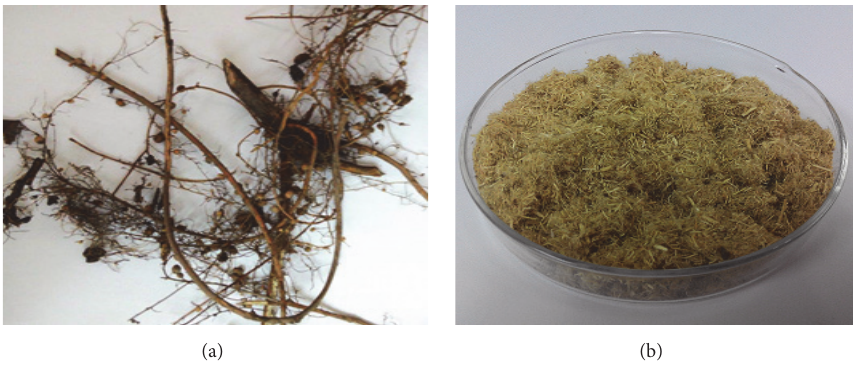
Figure 2: (a) Derris elliptica roots and (b) ground fine